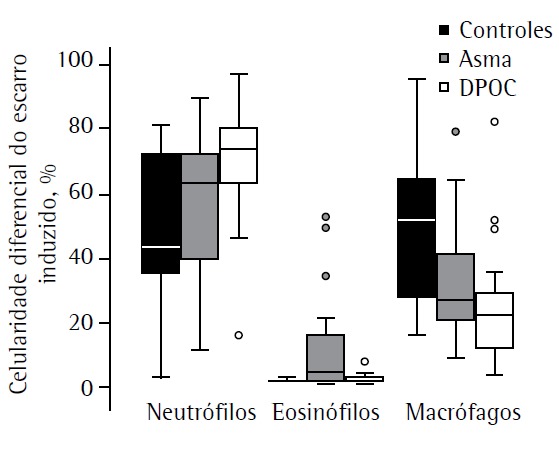
 Celularidade diferencial no escarro induzido nos três grupos do
estudo.